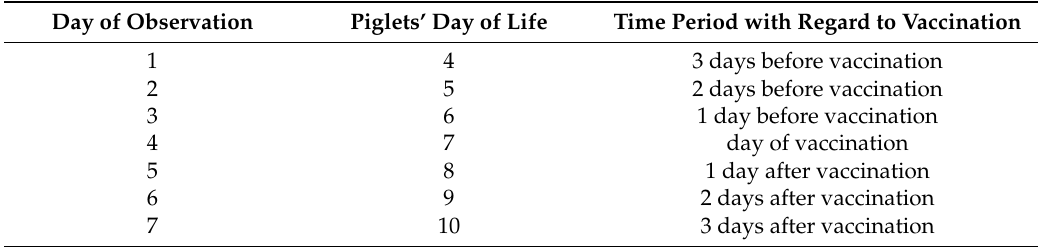
Table 1. Overview of observation days for video recordings, piglets’ day of life, and time periods. Day of Observation Piglets’ Day of Life Time Period with Regard to Vaccination 4 3 days before vaccination